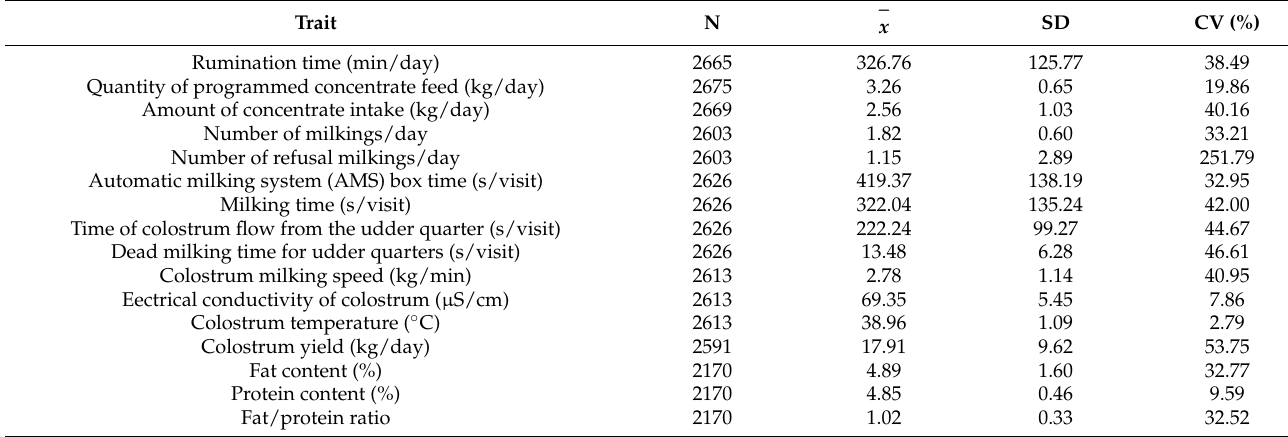
Table 2. Descriptive statistics of rumination, milking parameters and colostrum traits in the period from 1 to 4 days of lactation. Trait